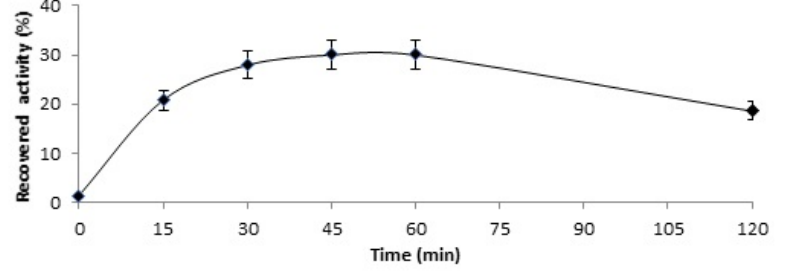
Figure 2. Optimized model validated for β -glucosidase immobilization via the CLEAs technique.